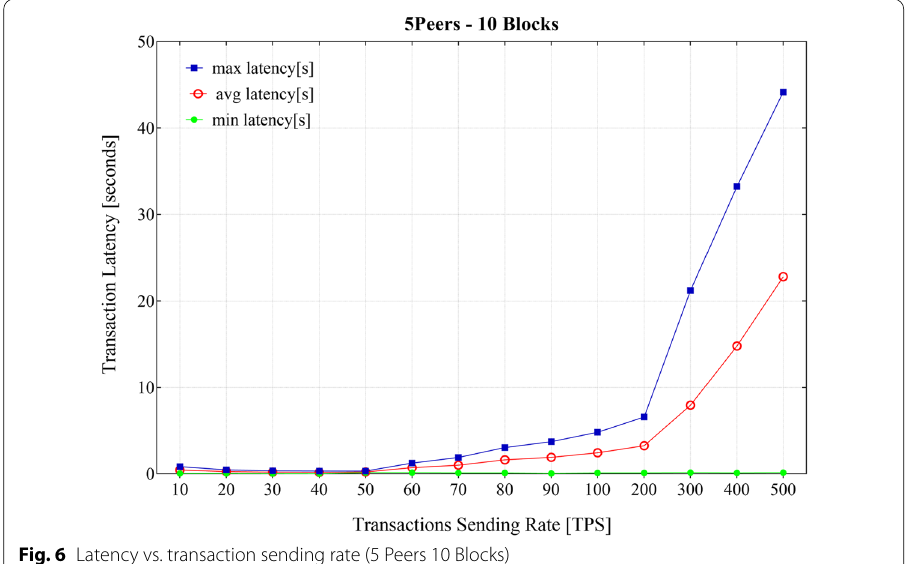
Fig. 6 Latency vs. transaction sending rate (5 Peers 10 Blocks)